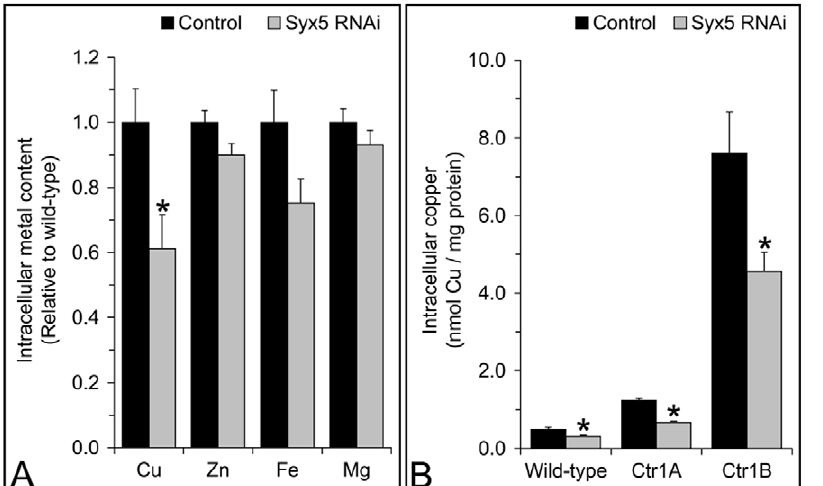
Figure 4. Syx5 suppression in Drosophila S2 cells decreases copper accumulation. Metal accumulation was measured by ICP-AES in control (black) and Syx5 (grey) RNAi suppression cells grown in basal media (A). Syx5 gene expression was suppressed to 19–36% of wild-type levels. Values are mean with s.e.m of eight replicates over two experiments, normalized against control cells. Mean copper accumulation during a 24 h exposure to 2 m M Cu was measured using 64 Cu in S2 cell lines stably over-expressing Ctr1A , Ctr1B or an empty vector control and normalized to total cellular protein (B). Error bars are s.e.m. from nine replicates over three experiments. Syx5 gene expression levels relative to wild-type were 18–41% (control cells), 25-41% (Ctr1A) and 23-31% (Ctr1B). Copper accumulation is reduced by Syx5 suppression (A) even when Ctr1A or Ctr1B is over-expressed (B): suppression of Syx5 reduces copper levels to 50–70% of wild-type in all cell lines. *Significant difference between control and Syx5 suppression cells, determined by an independent samples T-Test (P , 0.05).